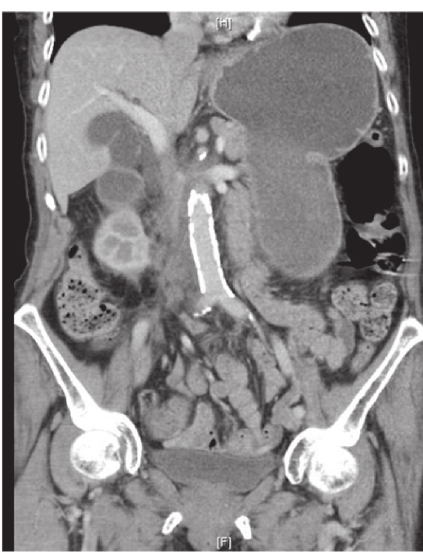
Figure 1: Coronal view of CT scan of the abdomen and pelvis showing wall thickening of the 2nd and 3rd parts of the duodenum and proximal distention of the 1st part of the duodenum and stomach.